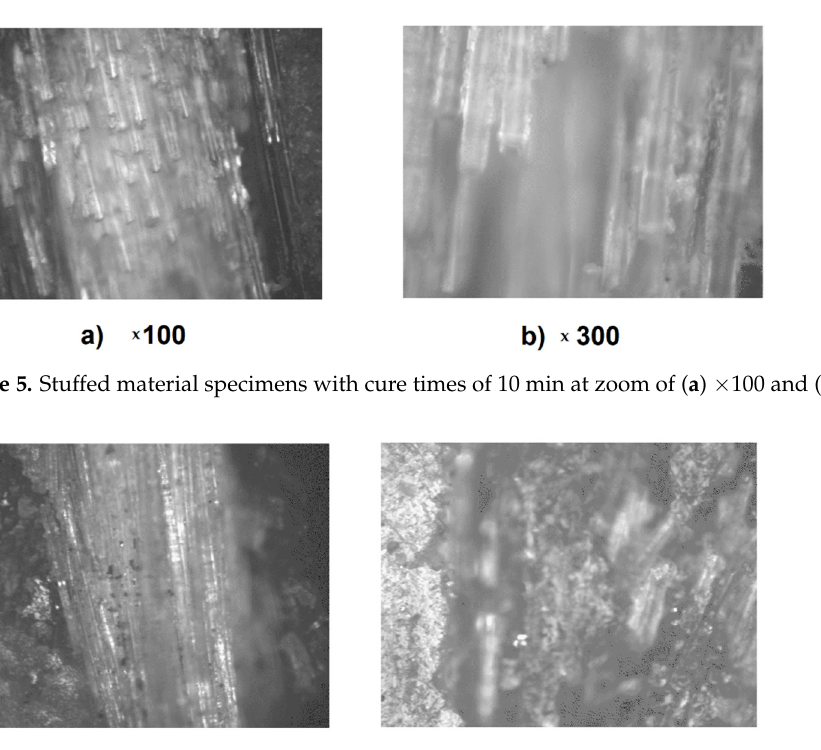
Figure 5. Stuffed material specimens with cure times of 10 min at zoom of ( a ) ×100 and ( b ) ×300.